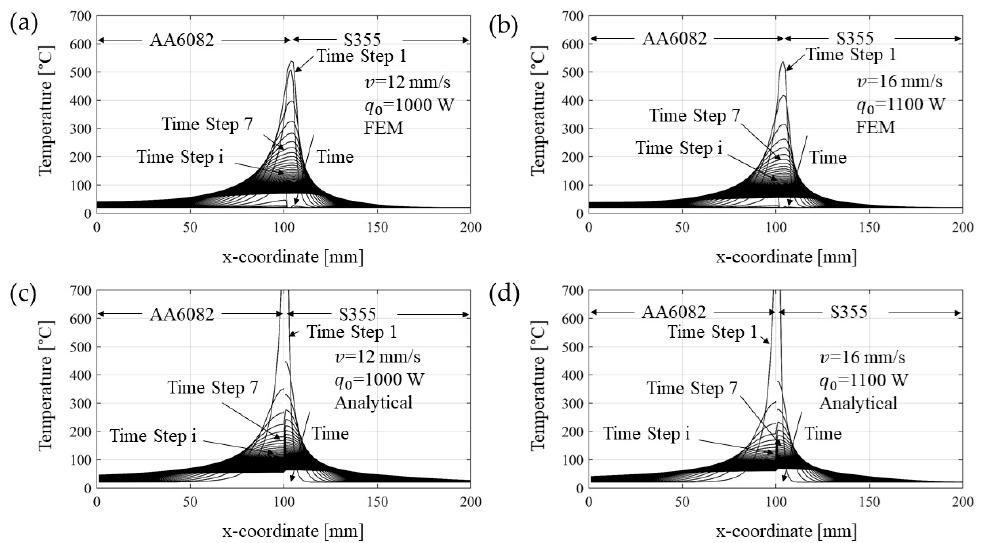
Figure 10. Temperature at different time steps for the welding speed of ( a , c ) 12 mm/s and ( b , d ) 16 mm/s and power input of ( a , c ) 1000 W and ( b , d ) 1100 W, respectively, calculated via ( a , b ) FE model and ( c , d ) via rapid analytical method. Temperatures values were taken considering the mid-thickness of a cross section taken orthogonal to the welding direction in the middle length of the plates.